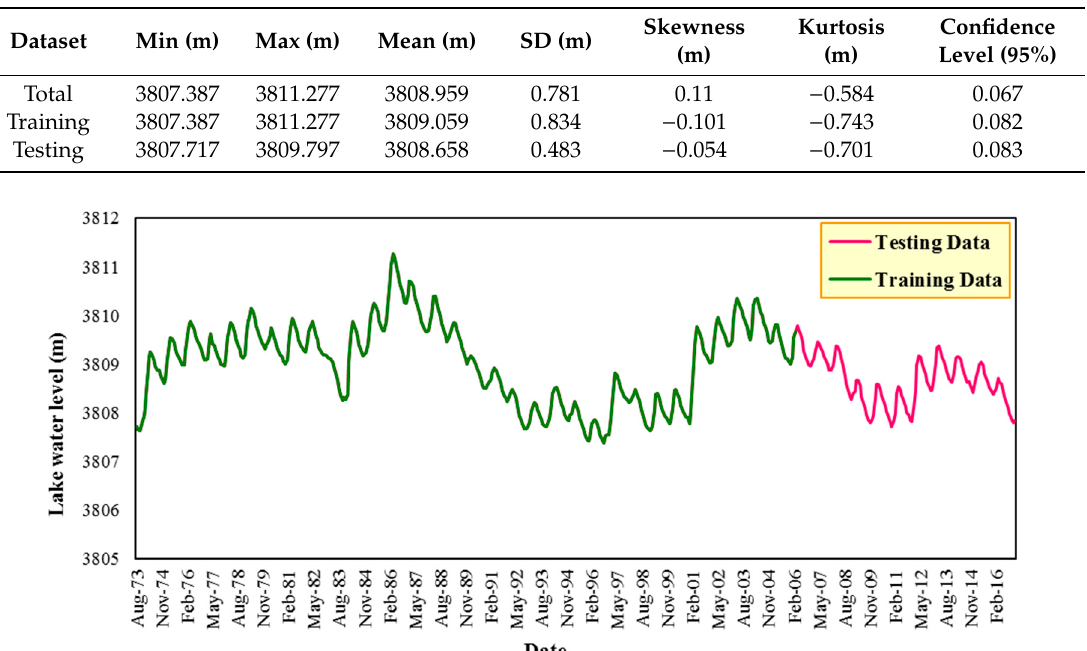
Table 1. Water level data used for the duration of the study period (1973–2017).